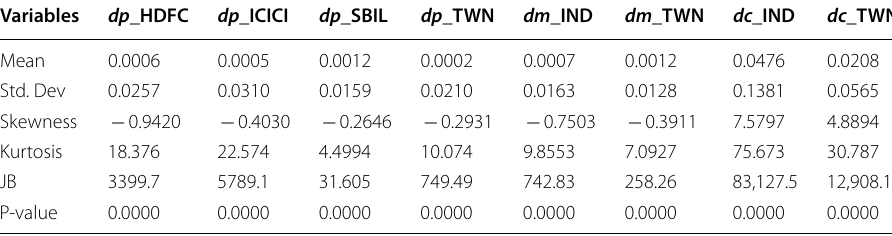
JB is the value of Jarque Bera for normality testing. The testing periods of lp _HDFC, lp _ICICI, and lp _SBIL is the research period indicated by the variables in the last column of Table 1. The testing periods of lm _IND and lc _IND are 2020/01/22 ~ 2021/0714, whichever is the most extended period for the test